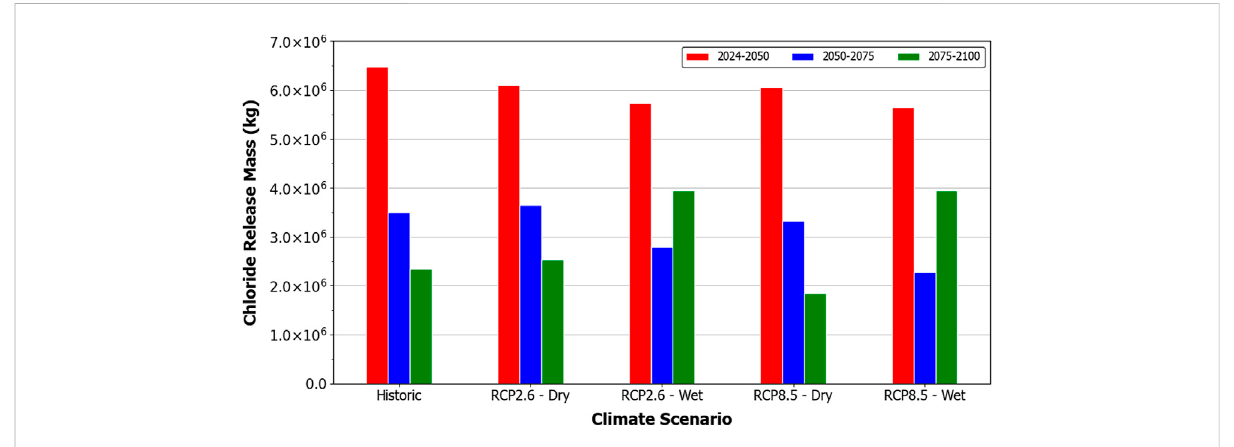
FIGURE 9 Cumulative (by period) chloride release mass for the different climate